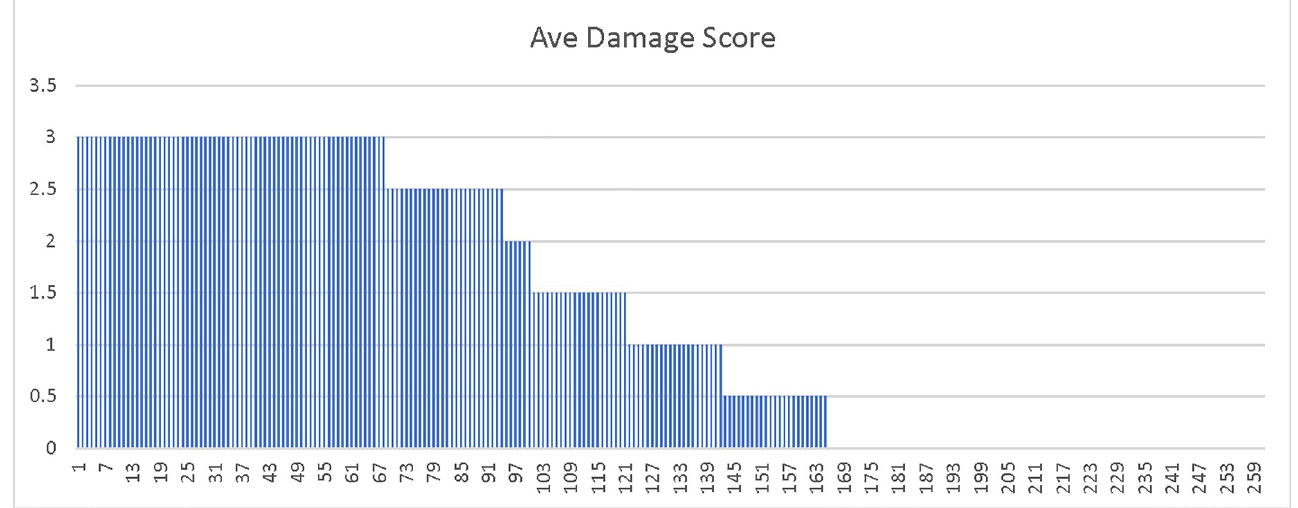
Fig 3. Damage scores from RIL families after low temperature stress. Damage score (see Fig 2 for a photographic representation of the 0–3 damage score ratings described in the methods section) representing an individual from each of 254 F2:F5 RIL families two weeks following low temperature treatments described in the methods section. The Y axis is the average damage score obtained from two independent ratings of the population.